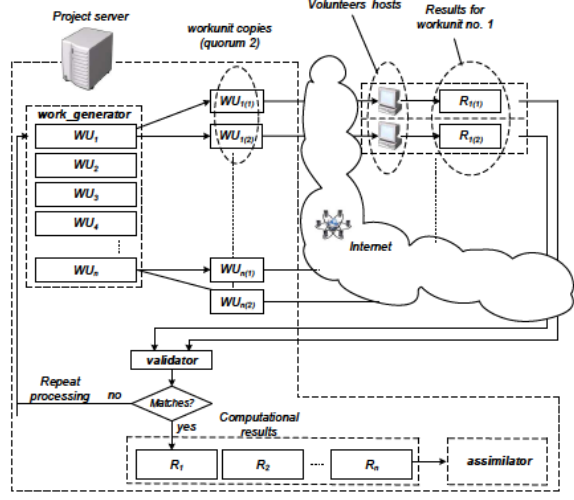
Figure 3: The scheme of a BOINC-based project with quorum of